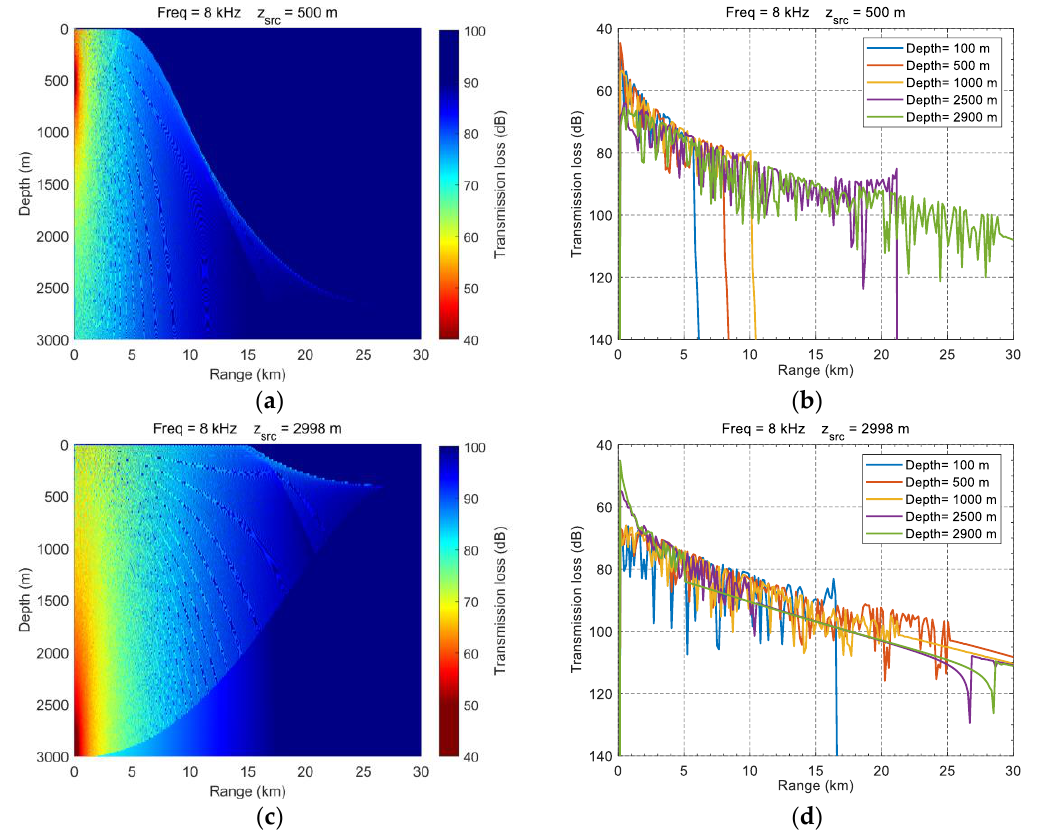
Figure 9. Signal transmission loss. ( a , b ) Signal transmission loss of the base station at 500 m depth and its variation with distance and depth; ( c , d ) signal transmission loss of the base station at 2998 m depth and its variation with distance and depth. Blue, orange, yellow, purple, and green colors in subfigures ( b , d ) denote user depths of 100 m, 500 m, 1000 m, 2500 m, and 2900 m, respectively.